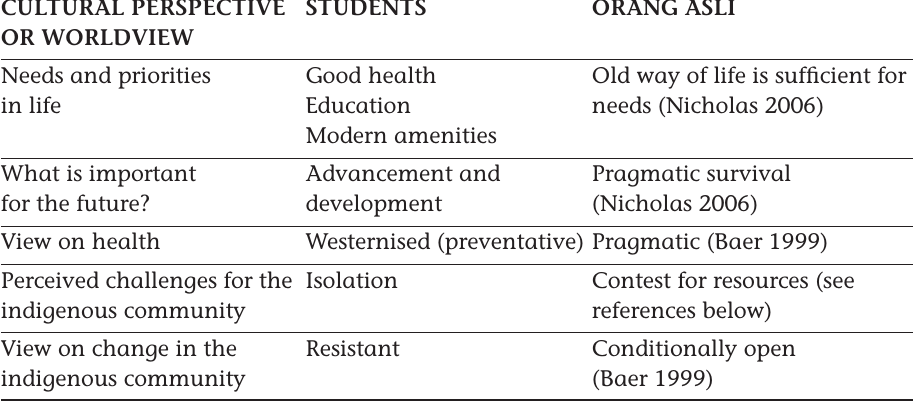
Table 1: Comparisons of cultural perspectives and worldviews of students and Orang